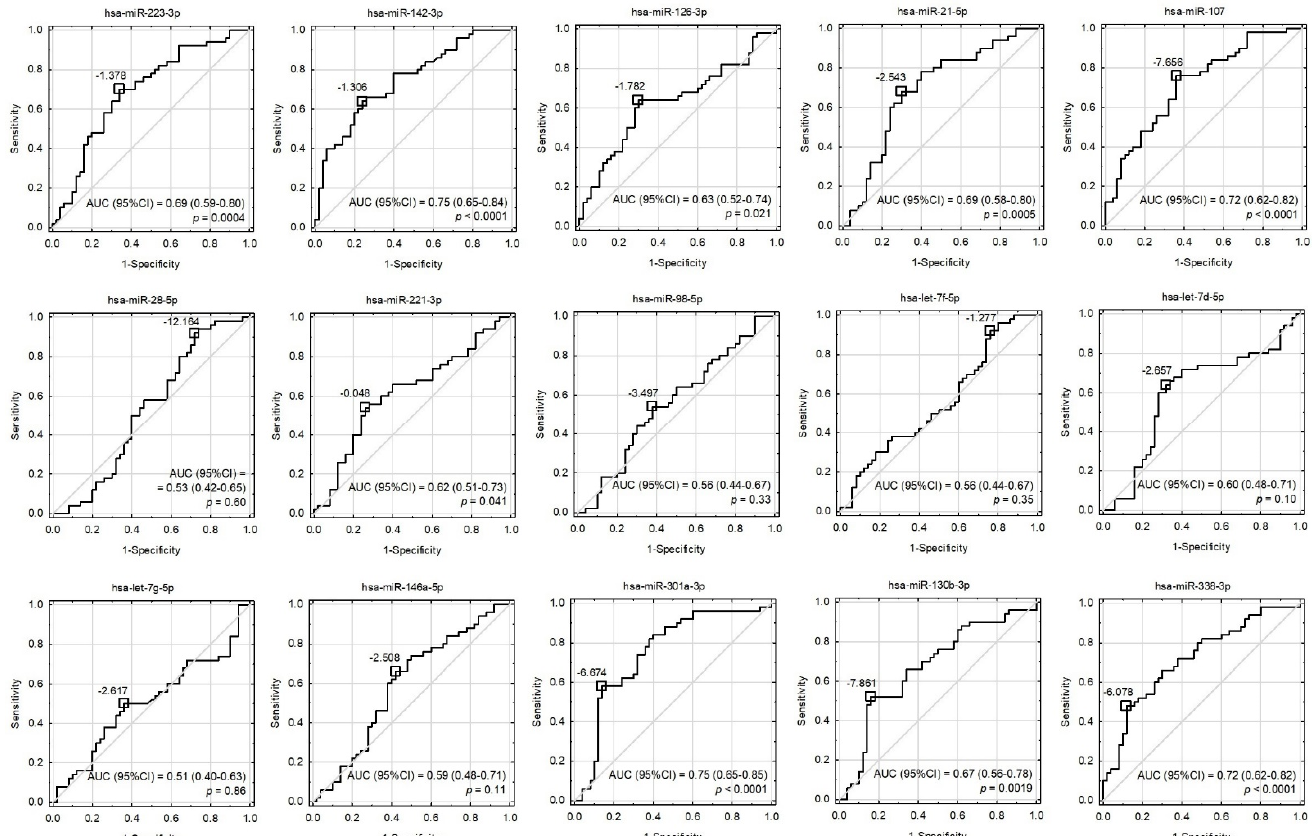
Figure 3. Receiver operating characteristic (ROC) curves for univariate models involving all the tested miRNAs. Cut-off points were proposed based on the maximization of Youden’s index and their values were presented as −Δ Ct. The area under the ROC curves (AUC), their 95% confidence intervals (95%CI), and the tests for AUC differences from 0.5 were displayed.